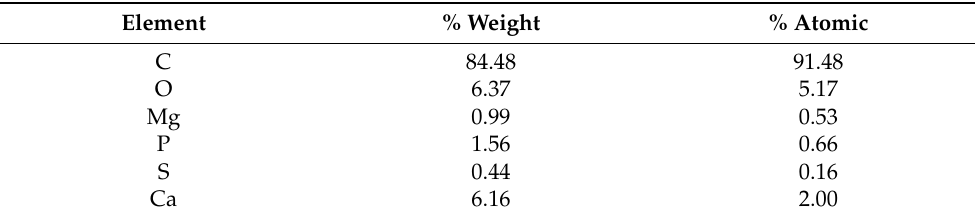
Table 2. EDS results of